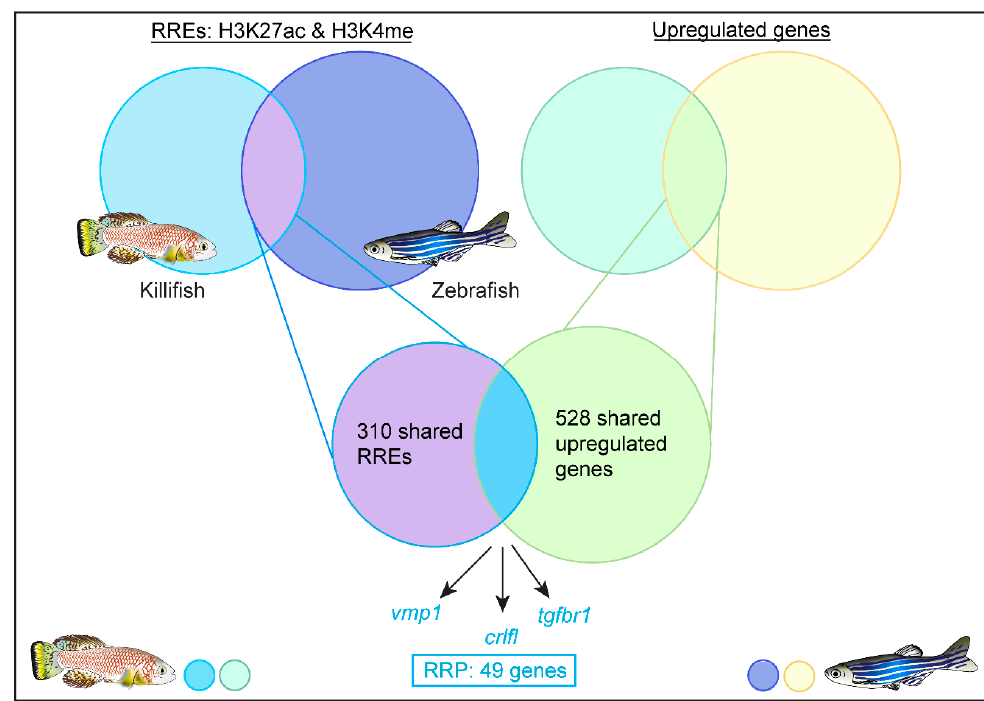
Figure 2. Identification of the 49 gene Regeneration Response Program (RRP). Direct comparison of ChIPseq data from the zebrafish and killifish identified 310 RREs that were activated upon injury. Direct comparison of bulk RNAseq data after fin injury identified 528 genes that were upregulated in both the zebrafish and killifish. A final direct comparison of the 310 shared RREs and the 528 shared upregulated genes led to the identification of the RRP: a genetic program of 49 genes that is activated in response to injury to drive successful